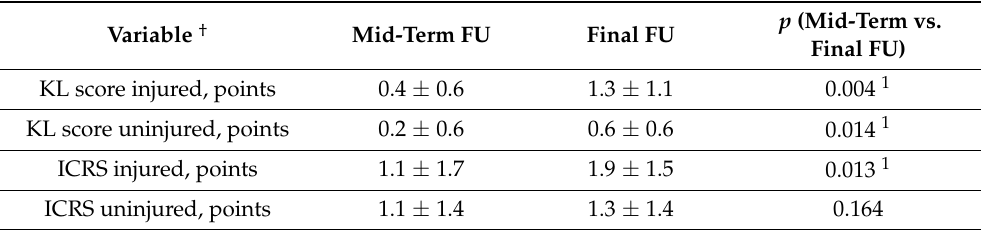
Table 3. Radiographic outcome at mid-term and final